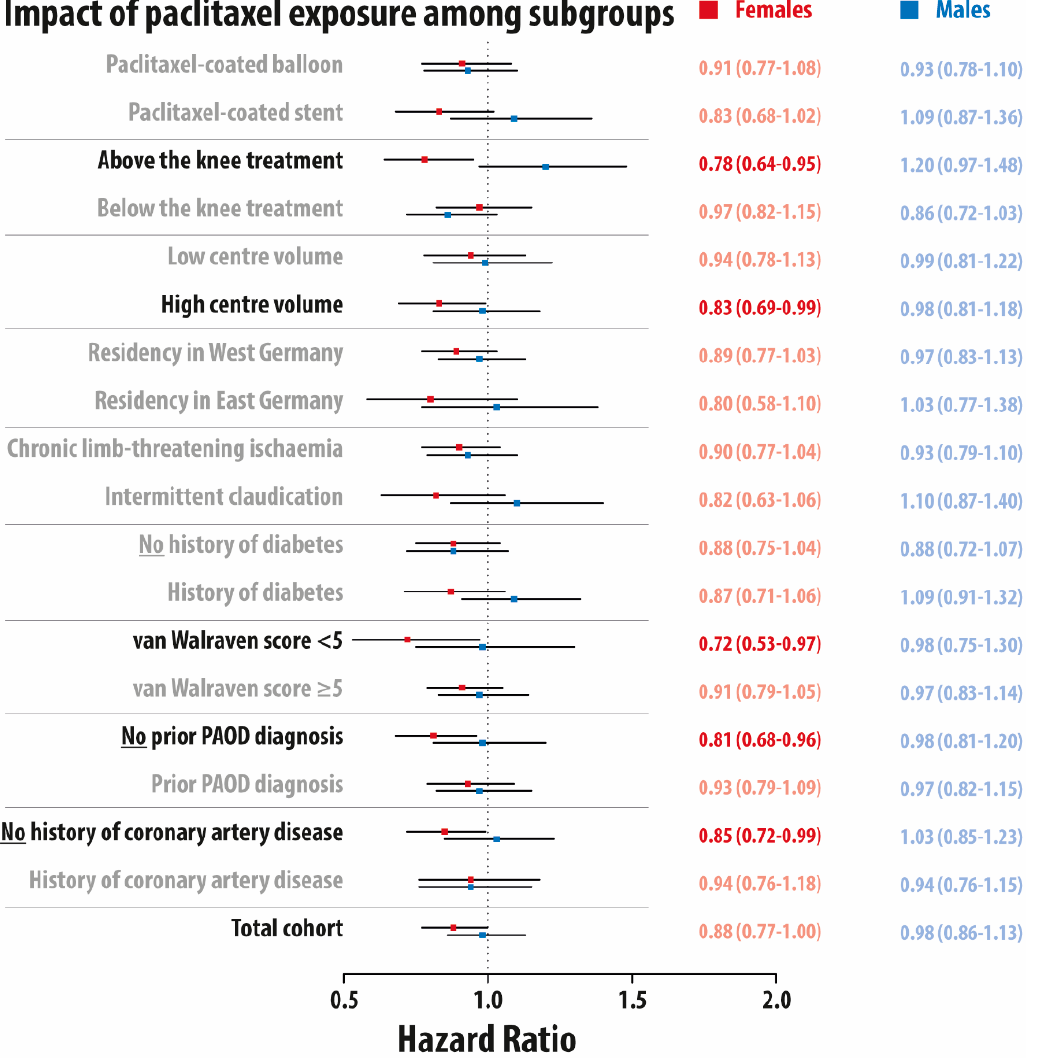
Figure 2. Forest plot for the adjusted impact of paclitaxel exposure on 5-year overall mortality among different subgroups stratified by sex (full cohort). Hazard ratio and 95% confidence interval in red for females and in blue for males. PAOD: peripheral arterial occlusive disease. All models were adjusted for all baseline characteristics using Cox models with regression adjustment.